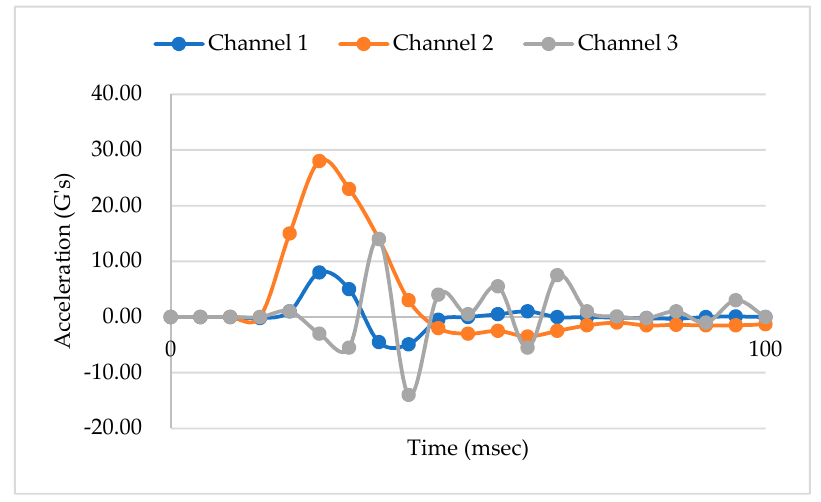
Figure 17. G’s value result from drop test.